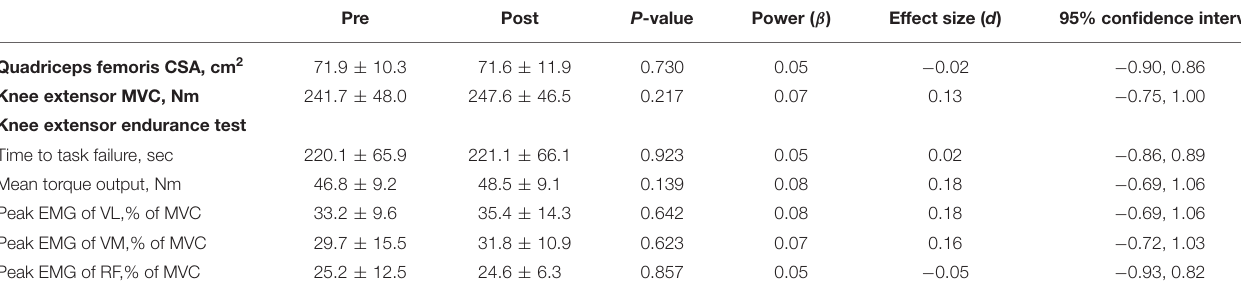
TABLE 2 | Changes in measured local muscle variables before and after a 2-weeks ischemic preconditioning intervention. Pre